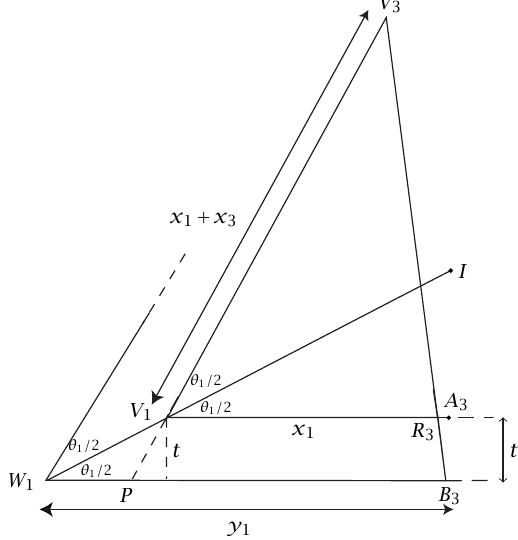
Figure 6 . The geometry for computing V 1 R 3